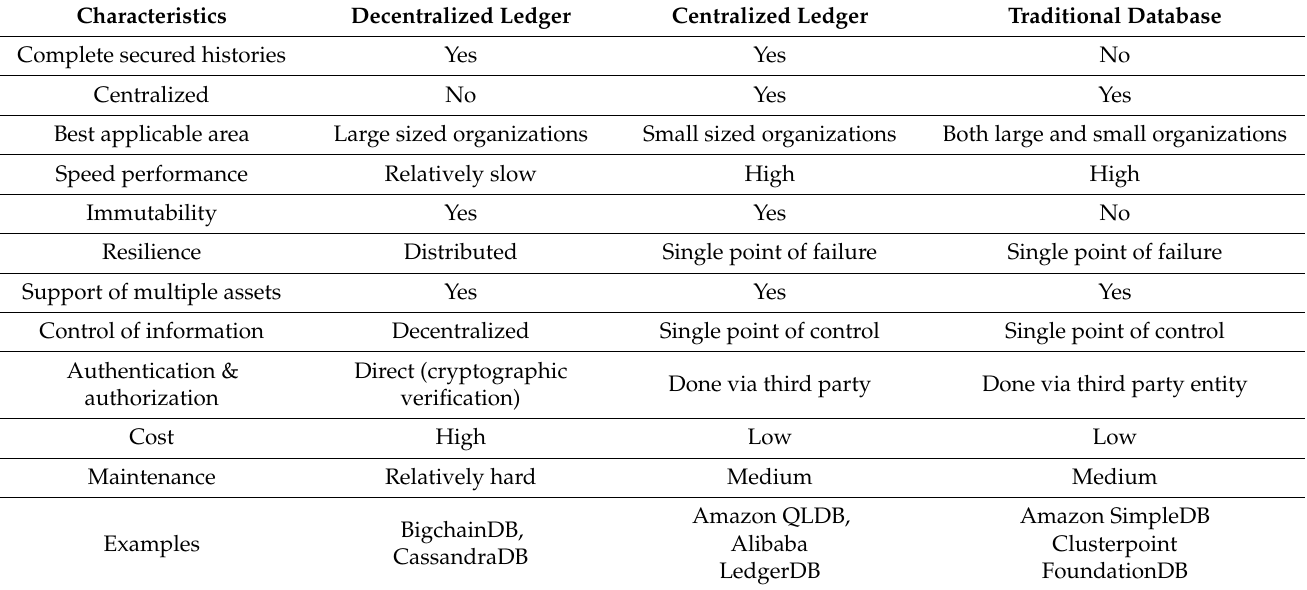
Table 5. Comparison of decentralized ledger, centralized ledger and traditional database